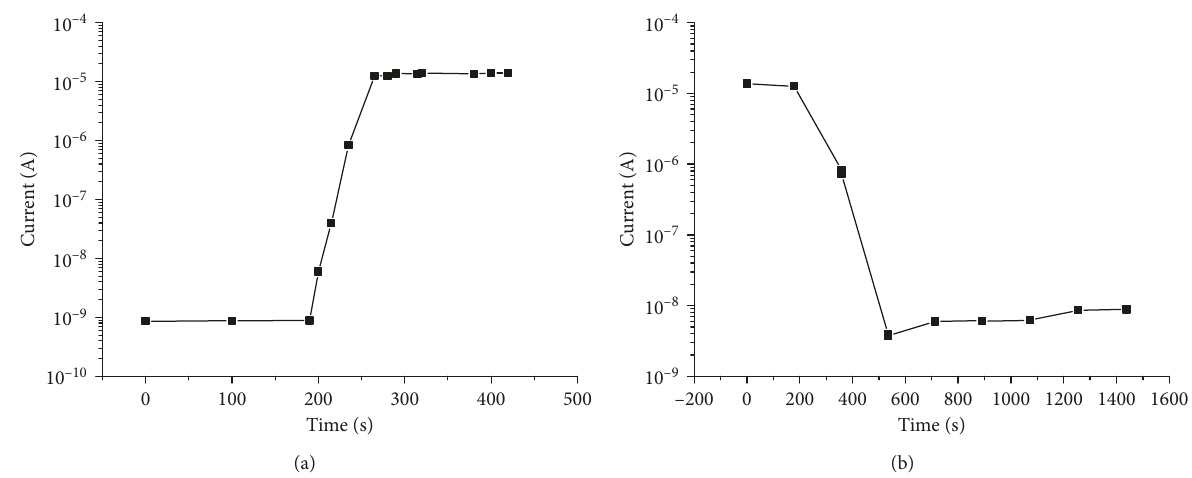
Figure 7: Current rise after the UV radiation source is switched on (a) and fall when it is switched off (b) for sample IZO5.